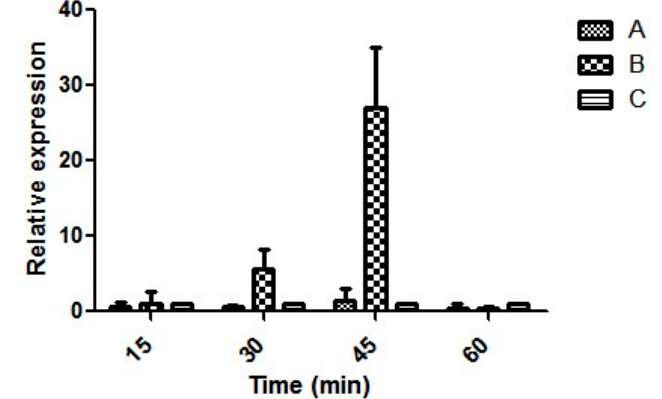
Figure 5. Relative expression of the rtxA1 gene in seafood isolate E4010 ( A ) V. vulnificus grown in Luria Bertani (LB) broth overnight at 37 °C incubated in Dulbecco’s Modified Eagle’s Medium (DMEM), (B) V. vulnificus grown in LB broth overnight at 37 °C was used to infect to HeLa cells at an MOI of 1:5, and ( C ) HeLa cells harvested at 0 h postinfection (control).